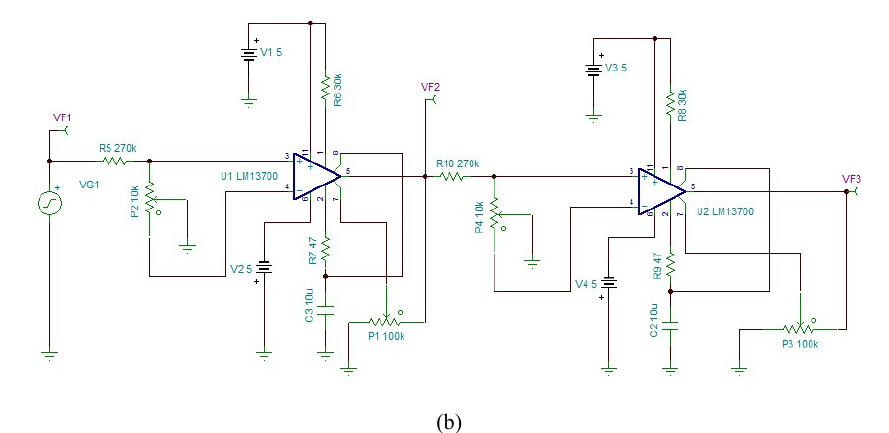
Fig. 5. AGC circuit: (a) configuration which is recommended from datasheet [35] ; (b) experiment set up of double AGC LM13700 using TINA-TI